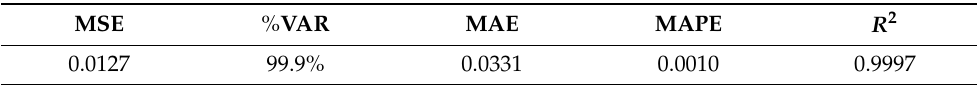
Table 4. Mean square error (MSE), % Variance Accounted for, Mean Absolute Error (MAE), Mean Absolute Percentage Error (MAPE) and R 2 averaged over 100 Monte Carlo